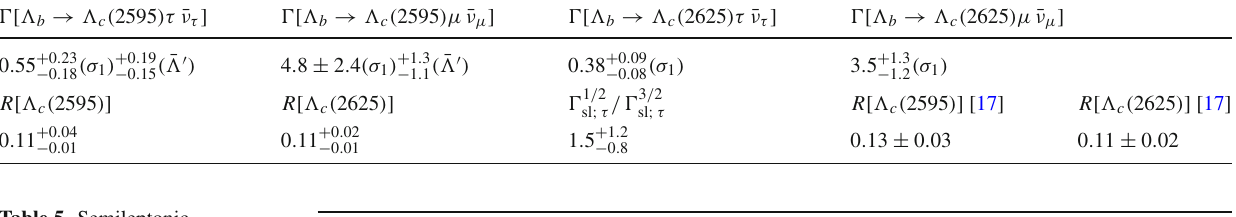
Table 4 Semileptonic decay widths (cid:6) [ (cid:2) b → (cid:2) ∗ c (cid:3) ¯ ν (cid:3) ] (in (cid:6) 0 / 100 units) for μ and τ modes. The rates are calculated using Eq. (26), with form-factors given in Eqs. (29) and (30) or equivalently in Eq. (32). They contain the subleading O ( 1 / m c ) corrections derived in Ref. [14], assuming that the (cid:2) c ( 2595 ) and (cid:2) c ( 2625 ) form the lowest-lying j P q = 1 − HQSS doublet. We also show the τ/μ − semileptonic ratios for both